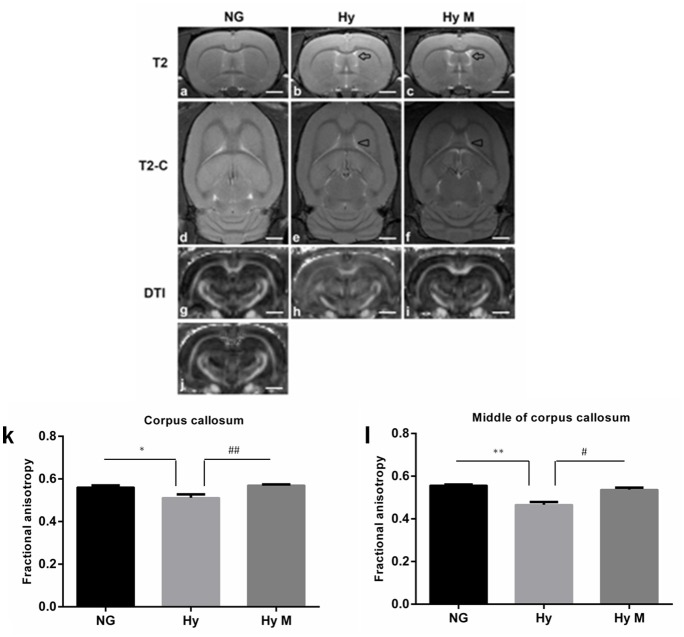
7T MRI/DTI images and the quantification of FA value in the targeted region of interest (ROI). (a–i) Representative T2, T2-C, and DTI images were obtained from the 13rd scanning section (with a clear CCM structure) of P60d rats in indicated groups. Arrows in T2 images indicated expanded septum and lateral ventricles. Arrowheads in T2-C images indicated the regions with reduced myelin sheath direction and destroyed myelin structure. (j) Illustration of the CC and CCM areas where the FA values were calculated. (k,l) The average of FA value of corpus callosum (CC) (k) and middle of CC (l) were measured and analyzed among indicated groups. *p < 0.05 and **p < 0.01 vs. NG group. #p < 0.05 and ##p < 0.01 vs. Hy group. n = 5 animals per group. Data expressed as means ± SEM. NG represents normal control rats; Hy represents hypoxia rats; Hy M represents hypoxia rats with minocycline treatment. Scale bar = 2.5 mm.